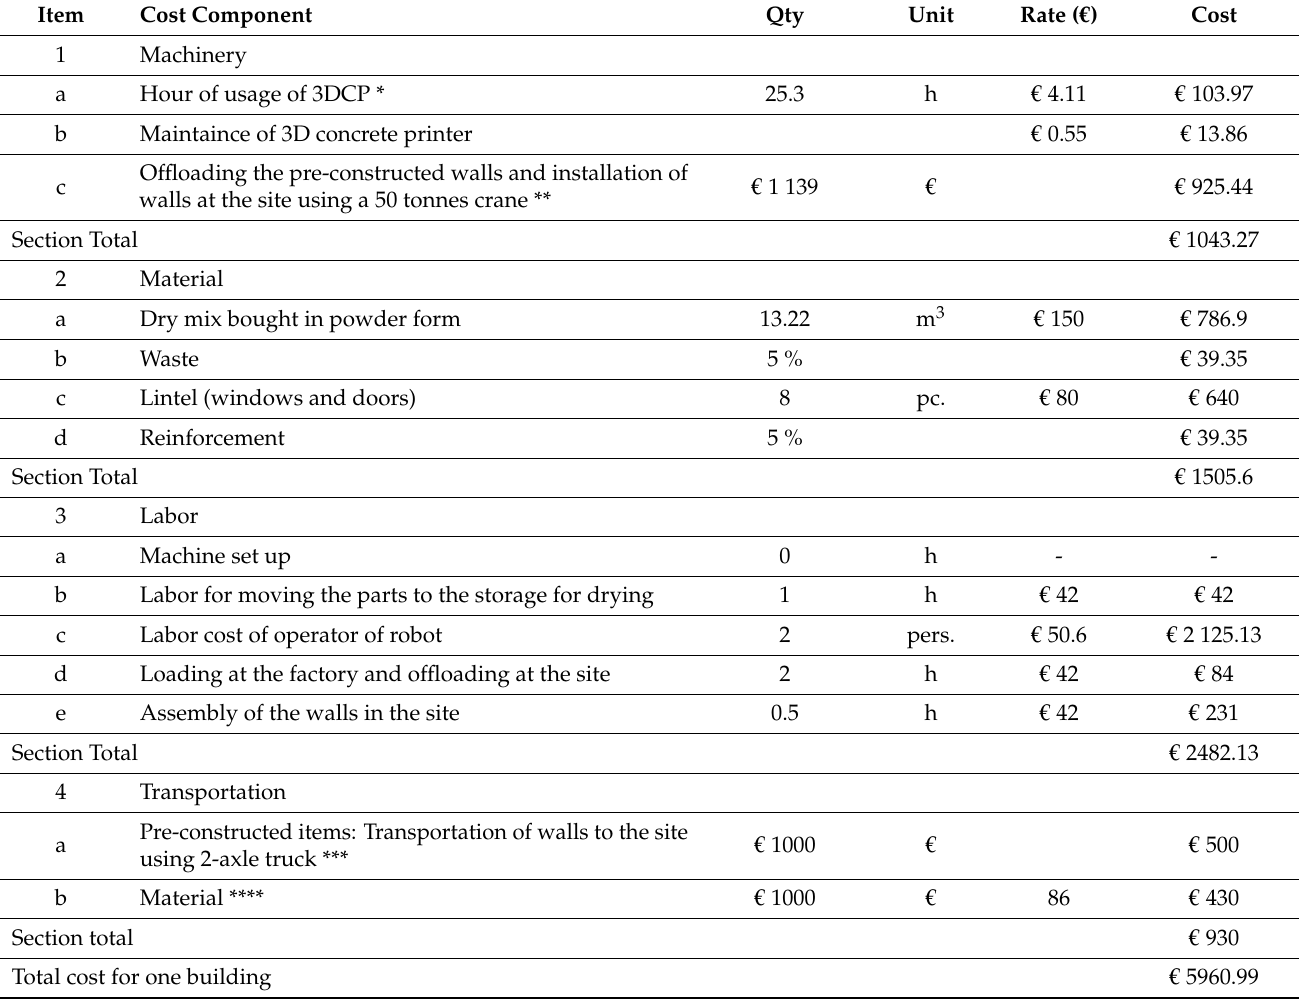
Table A6. Scenario 5 cost model in detail.